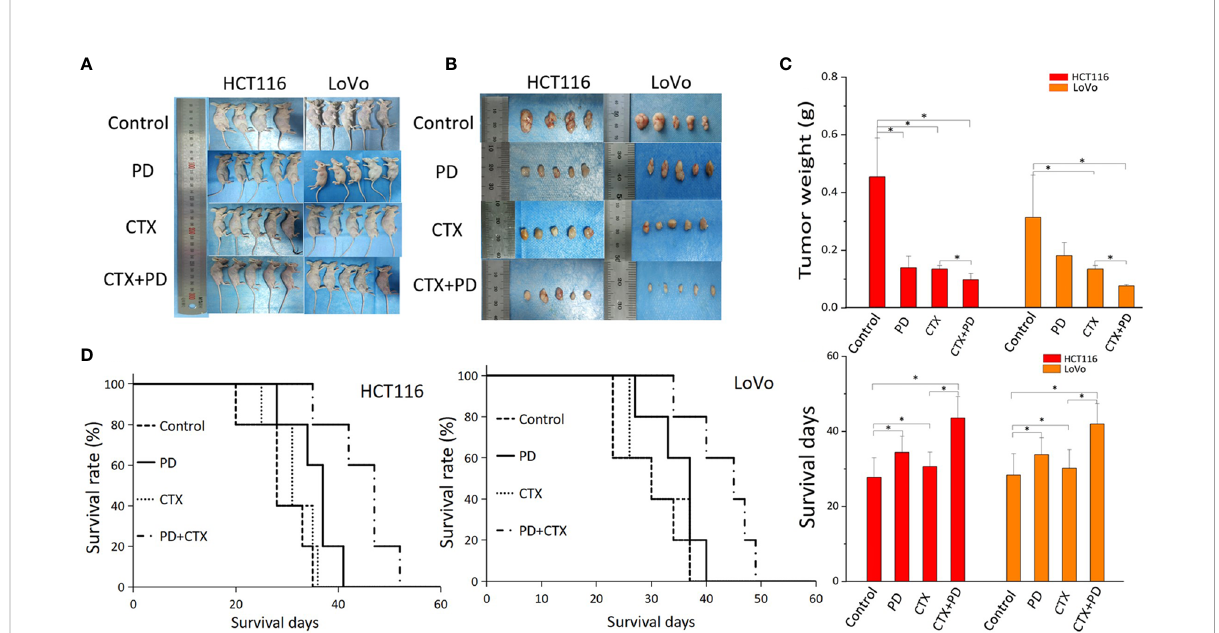
FIGURE 6 The antitumor ef fi cacy of co-treatment with PD and CTX in subcutaneous tumor models. (A) Subcutaneous tumor models of HCT116 and LoVo cells were collected after the mice were sacri fi ced. Each group contained fi ve mice, but one mouse of the HCT116 control group died during the experiment. (B) After sacri fi ce, subcutaneous tumors were removed and photographed. (C) Tumor weight was measured using an electronic balance. The mean ± S.D. is shown. One-way ANOVA was performed used to analyze P values between groups. All groups are compared with the ‘ control ’ group, the ‘ CTX ’ group is compared with the ‘ CTX+PD ’ group. *P < 0.05 represents a signi fi cant difference. (D) Survival curves of each group. Survival days of other groups are compared with those of the control group; the ‘ CTX ’ group is compared with the ‘ CTX+PD ’ group. *P<0.05 represents a signi fi cant